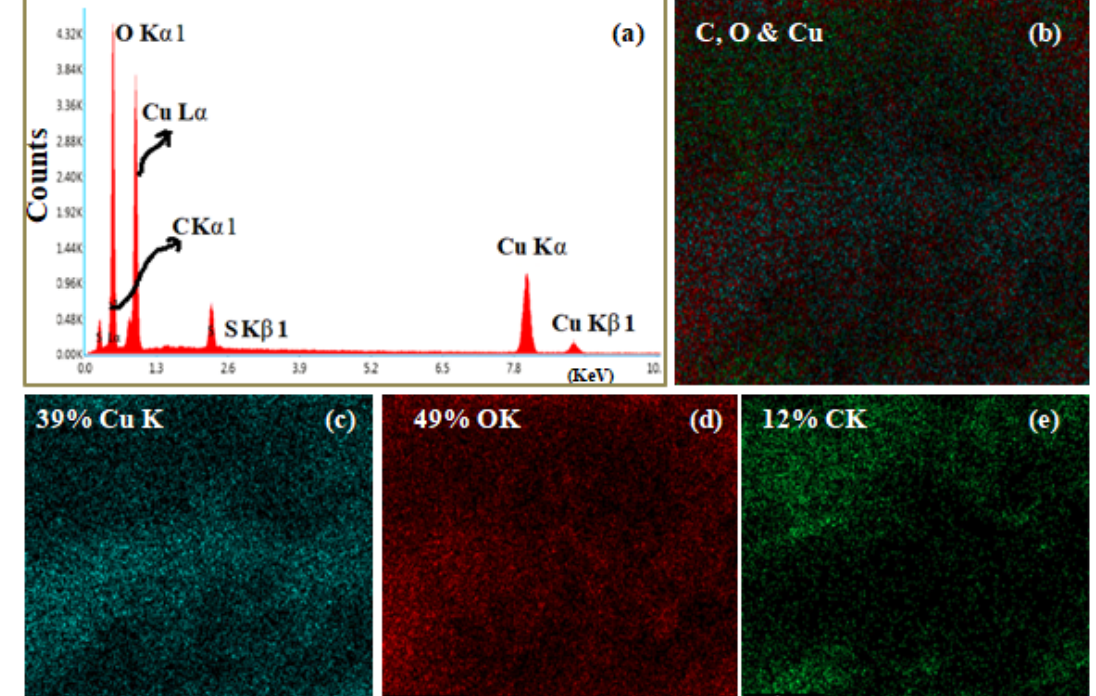
Figure 3. ( a ) EDAX analysis and ( b – e ) EDS mapping of the synthesized rGO-CuO composite. FTIR spectroscopy helps in identifying the existence of the vibrational frequencies in the synthesized rGO/CuO nanocomposite as shown in Figure 4. The peak at 1117 cm −1 attributes to C–O stretching vibrations, and the characteristic peak at 1566 cm −1 shows the